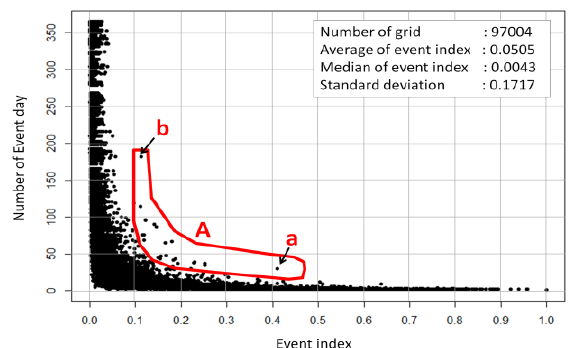
Figure 12. Relationship between the event indexes with the number of Event day in 2012